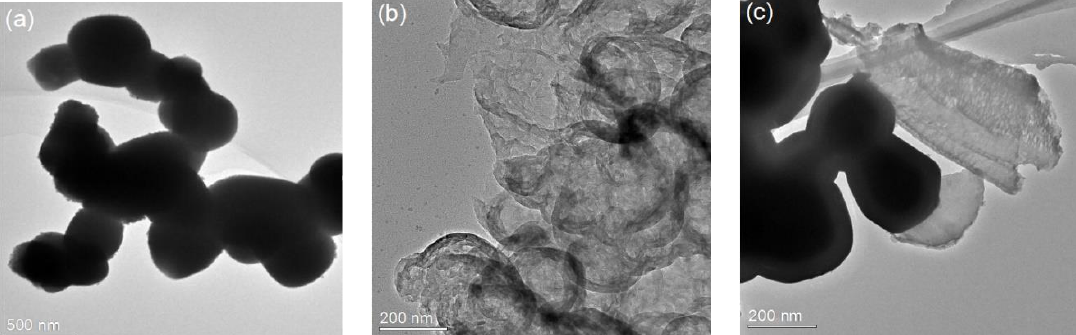
Figure 2. TEM images of ( a ) Ag 3 PO 4 , ( b ) g-C 3 N 4 , and ( c ) Ag 3 PO 4 /g-C 3 N 4.